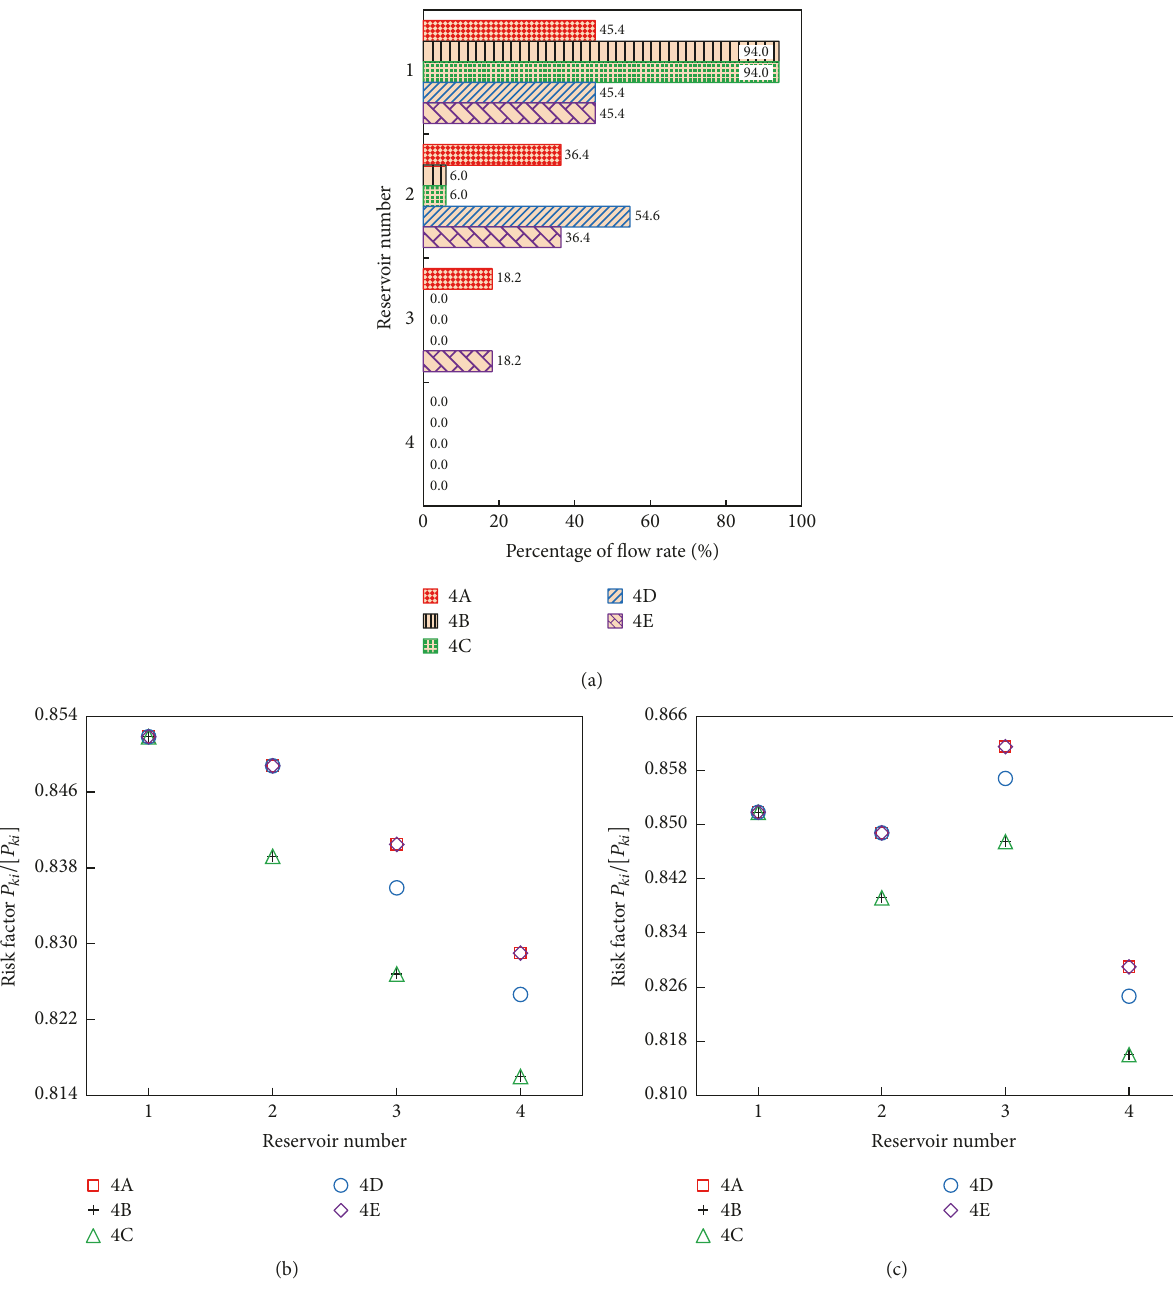
Figure 8: Proportions of the inflows (a) and risk factors of each reservoir for different reservoir thicknesses for the two scenarios of the conceptual engineering model. (b) and (c) are the risk-factor results for Scenarios S-1 and S-2, respectively.